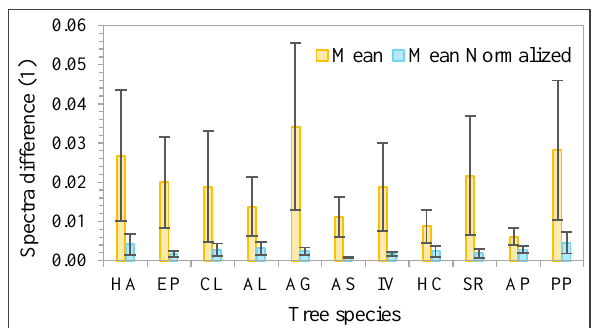
Figure 4. Spectra difference within-species considering the mean spectra and the mean normalized spectra for each sample From results obtained using the mean normalized spectra (Figure 4) it is possible to see that the within-species differences presented lower values as well as degrees of variation. Thus, can be suggested that the use of normalized spectra decreases the variability from samples belonging to the same class. Differences in crowns illuminations caused by the acquisition’s geometry and trees structure are reduced when using the normalized values and could improve the classifier